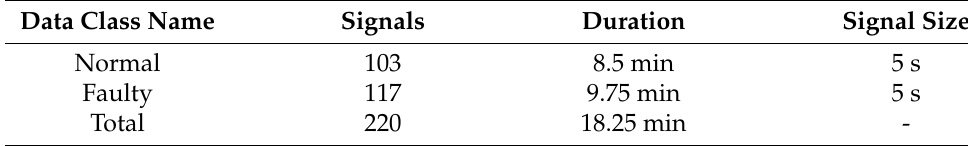
Table 1. Details of the acquired